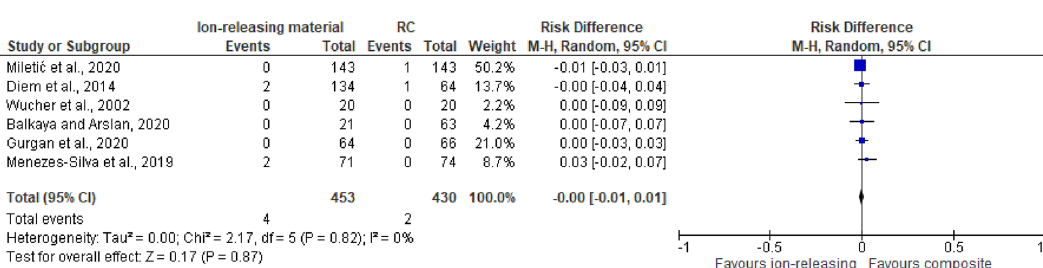
Figure 4. Forest plot of comparison: Ion releasing restoration versus resin composite, outcome: 1.2 Secondary caries for load-bearing